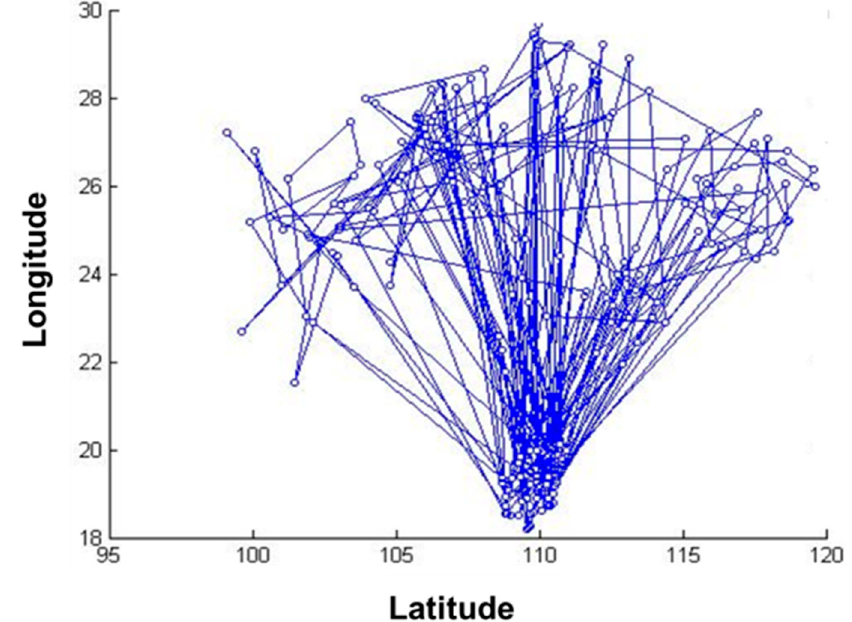
Figure 4. Running results of the genetic algorithm.